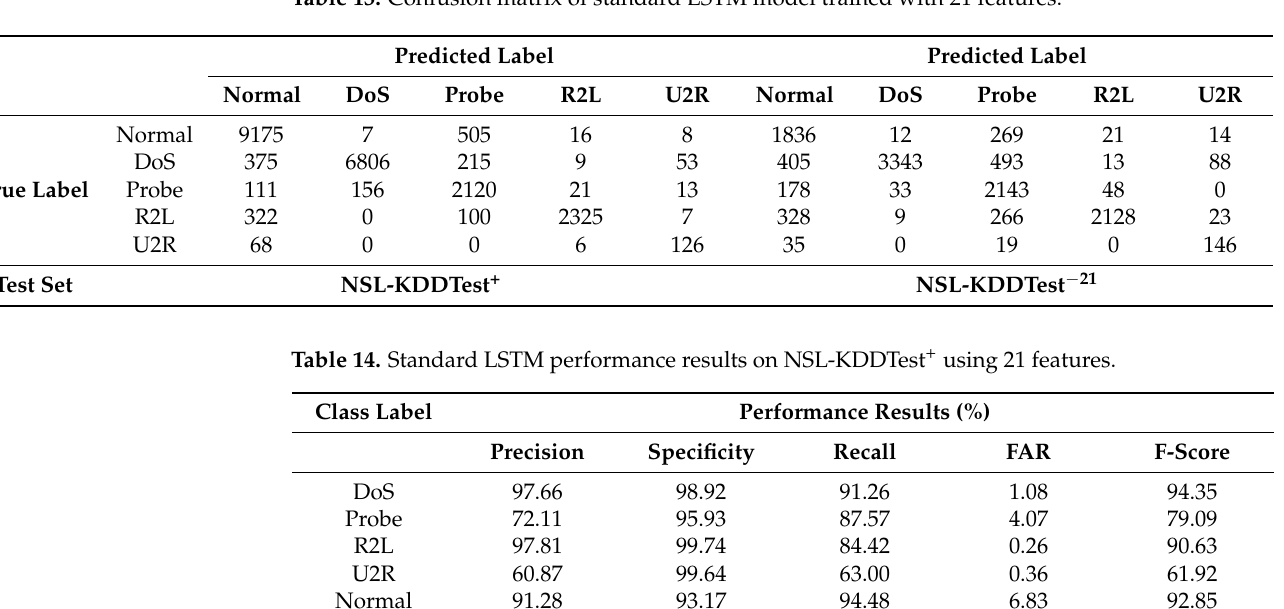
Table 13. Confusion matrix of standard LSTM model trained with 21 features.